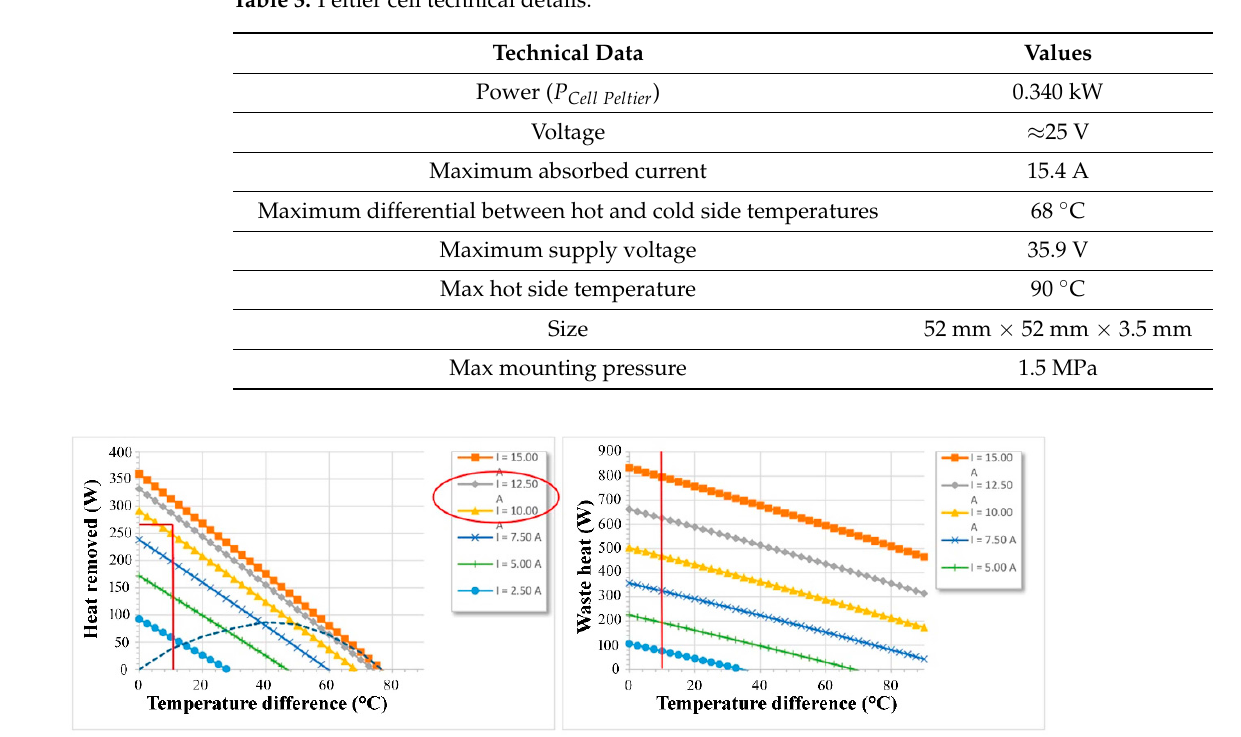
Table 3. Peltier cell technical details.